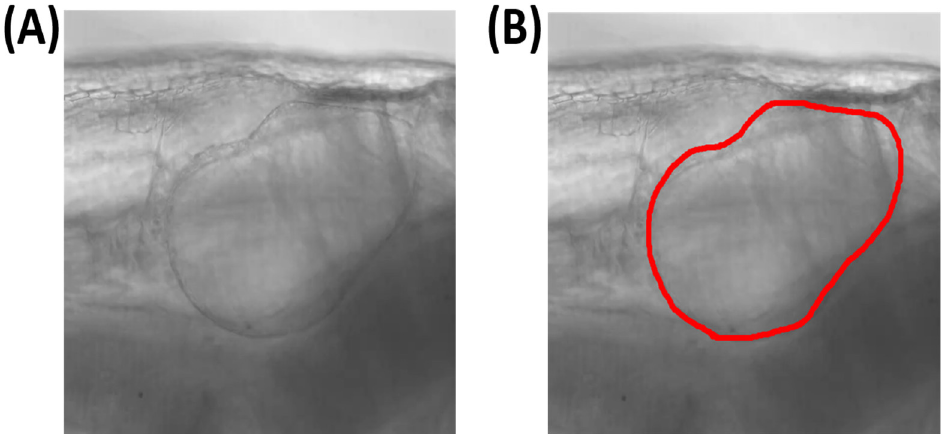
Figure A1. The image of the heart chamber of D. magna before ( A ) and after ( B ) manual marked with red color line.